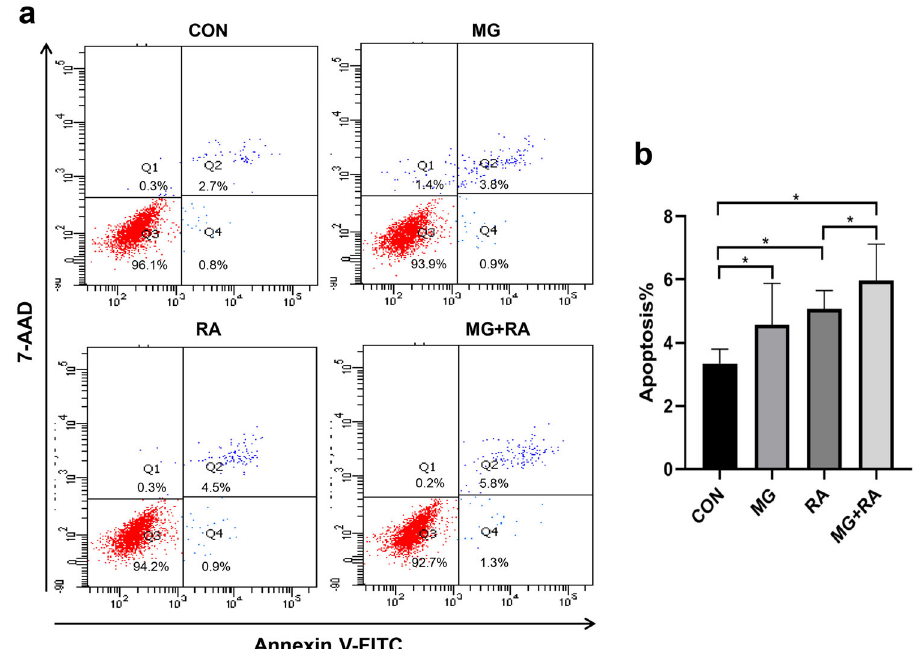
Fig. 3 Clinorotation and X-ray radiation increased osteoblast apoptosis in MC3T3-E1 cells as evidenced by Flow cytometry. a Flow cytometric analysis of apoptosis in osteoblasts stained with Annexin V-FITC. b Apoptosis rates of four groups in MC3T3-E1 cells ( n = 3) which were re fl ected by the sum of Q2 and Q4 quadrant. The data are expressed as the mean ± SD. * P < 0.05, ** P < 0.01, *** P < 0.001, ns not signi fi